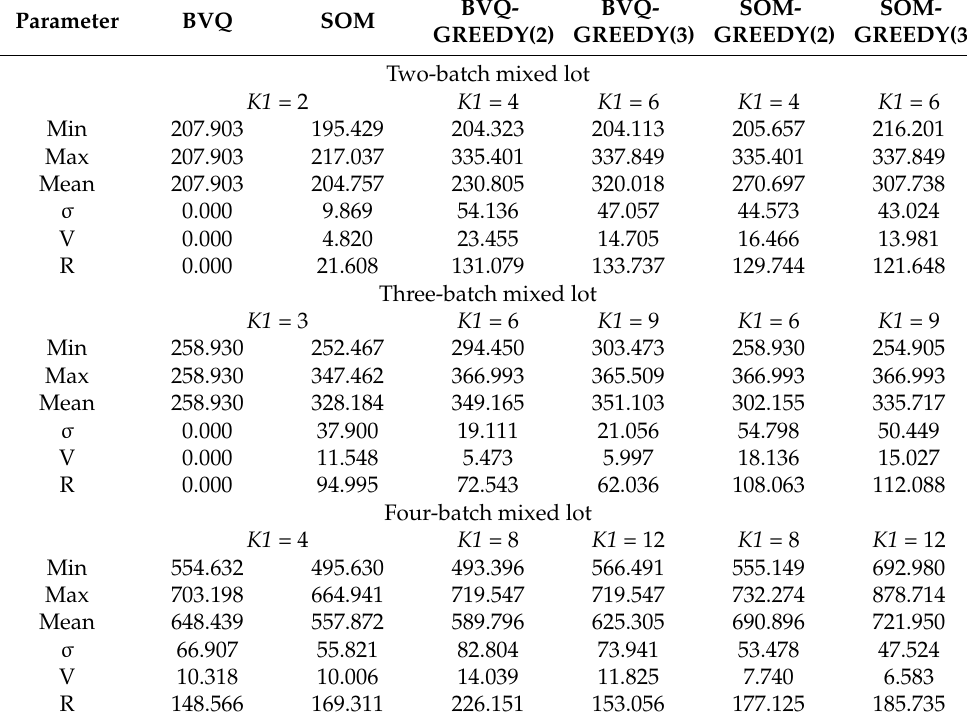
Table A2. Objective function value summarized after 30 attempts (Chebyshev distance, initialization by